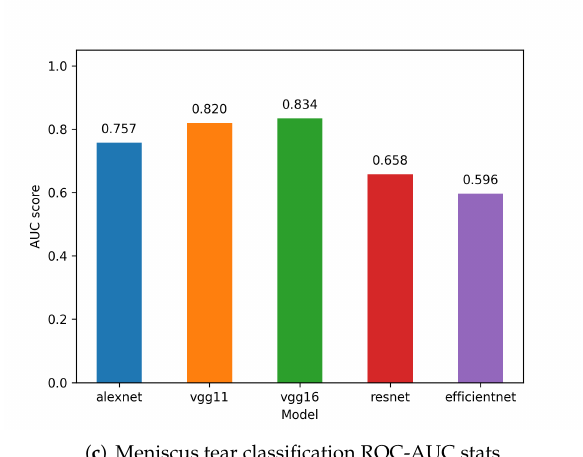
Figure 6. ROC-AUC stats for each model and for each diagnosis type: ( a ) general abnormality classification, ( b ) ACL tear classification, ( c ) meniscus tear